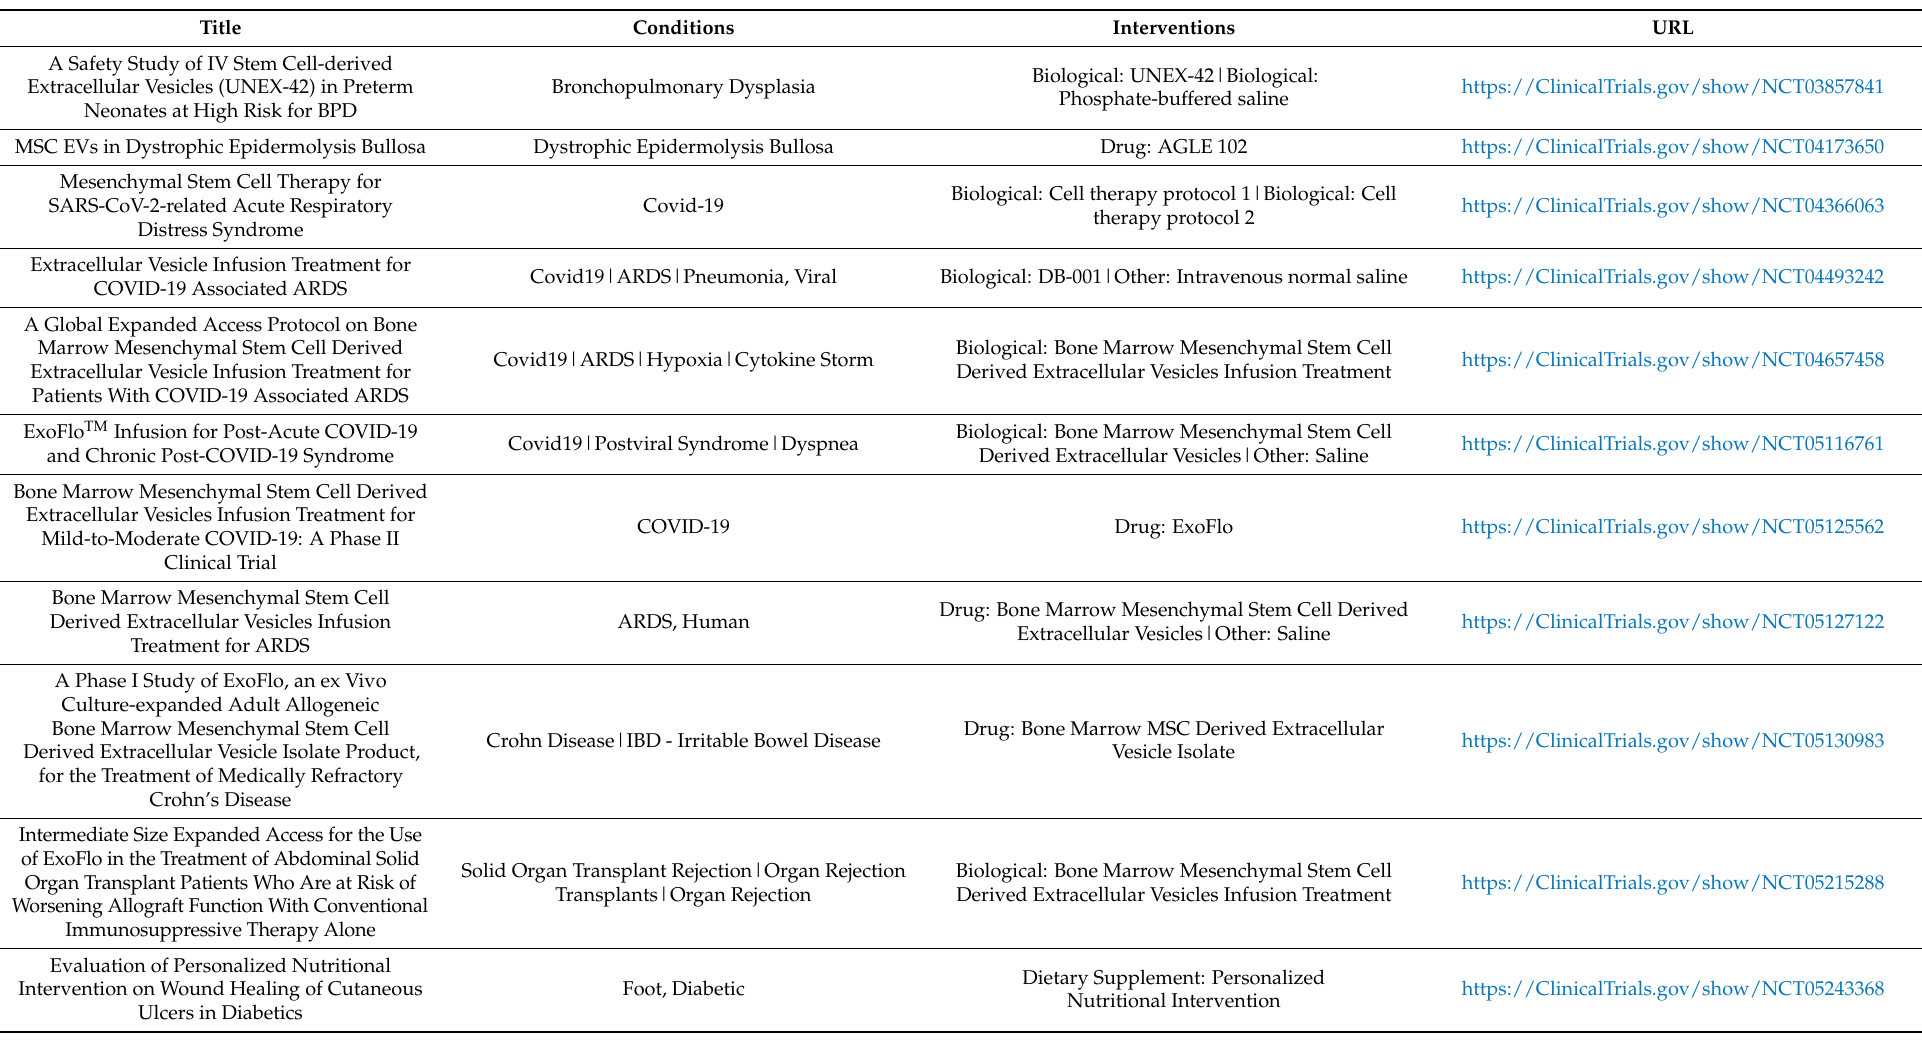
Table 1. List of registered clinical trials using MSC-EVs. (Source: Clinicaltrials.gov; accessed on 18 March